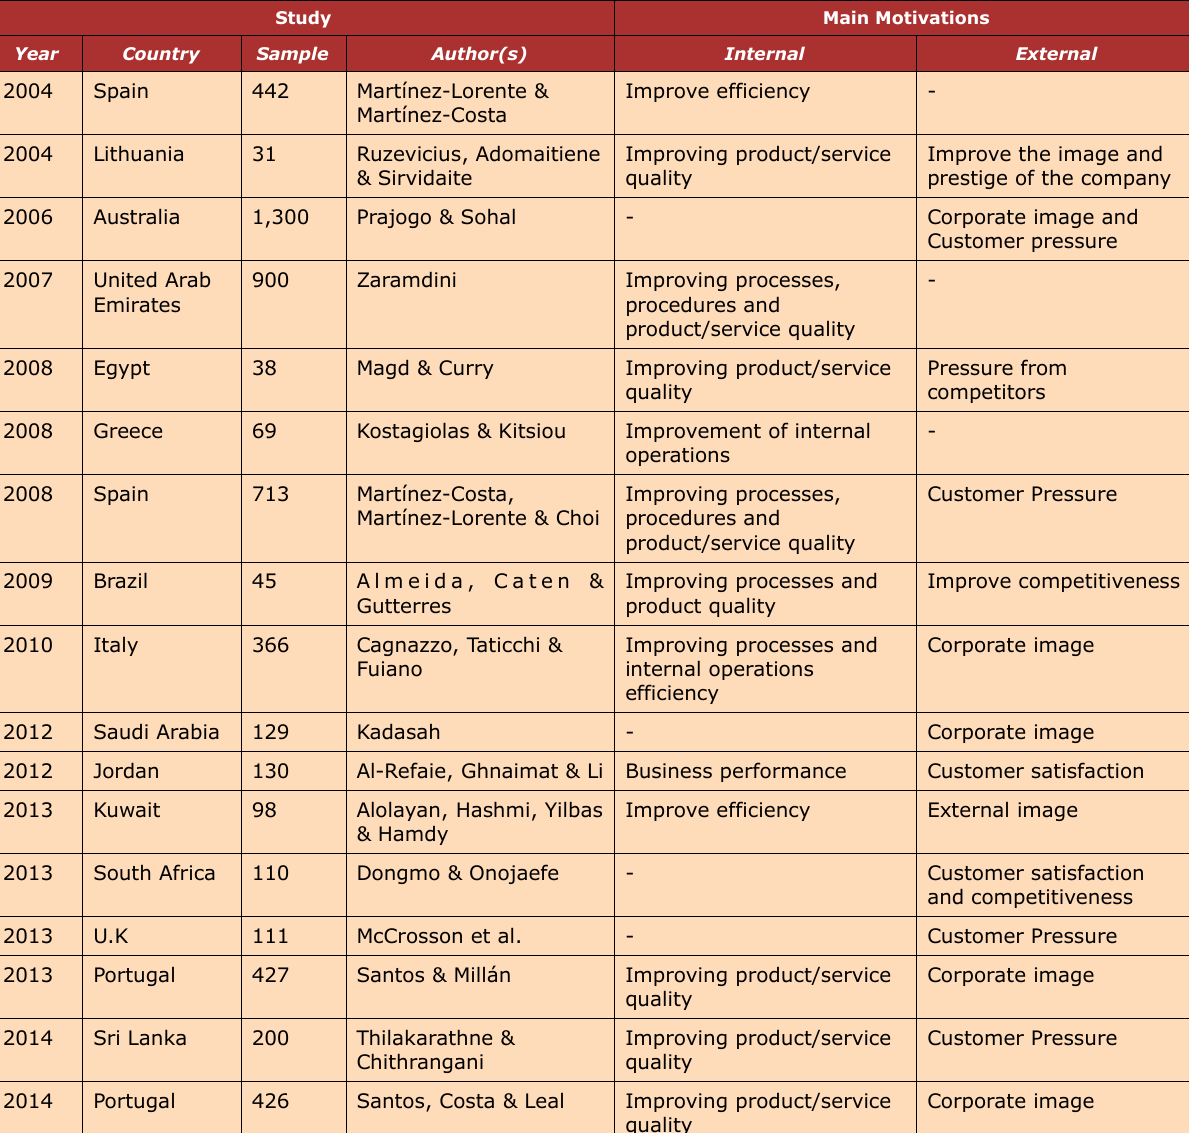
Table 1. Motivations for adoption of ISO 9000 family of standards - Review of Literature (*empirical studies